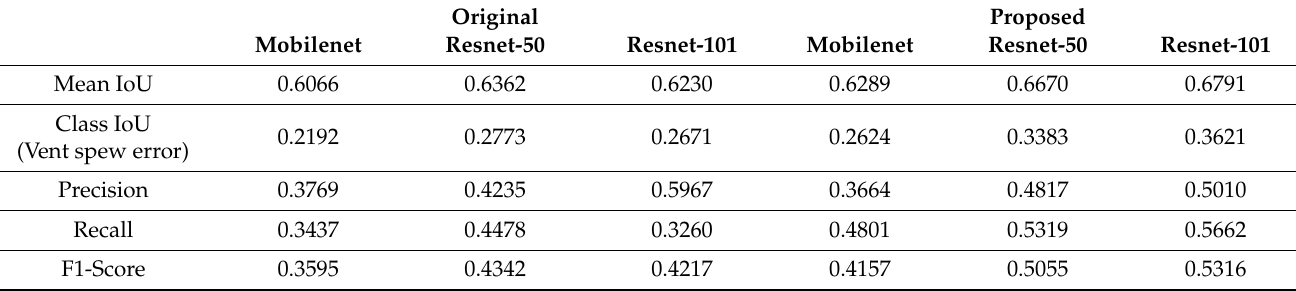
Figure 14. Trained network–based test results; the left side of each image is the ground truth, while the right side is the inference result. Table 2. Original/proposed training results for various underlying